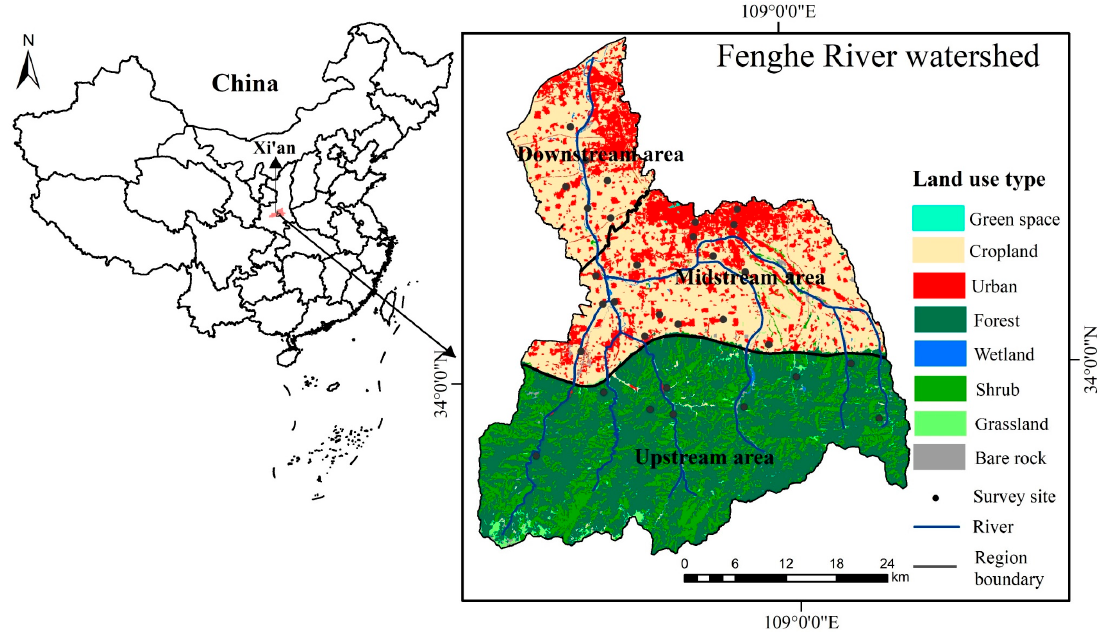
Figure 1. The location map of the Fenghe River watershed.